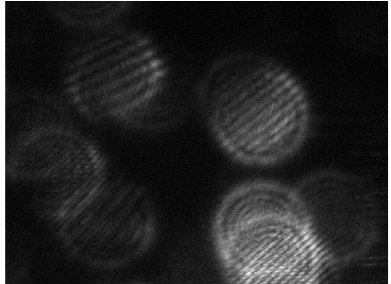
Figure 6. Interference fringe image of 24 μm standard particle field.